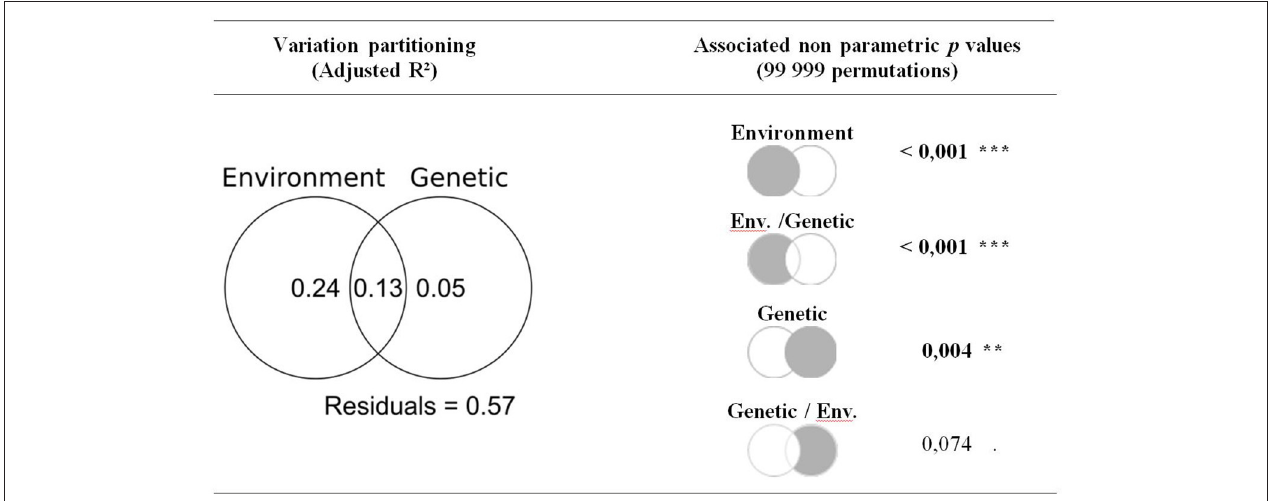
FIGURE 5 | Multivariate variance partitioning of environmental variables (Equation 1) and genetic variables (Equation 2) to explain among-population variability in growth-climate relationships. Significance of each components of the variance partitioning were assessed through permutations (99 999) through redundancy analysis and partial redundancy analysis. Significant p -values are highlighted in